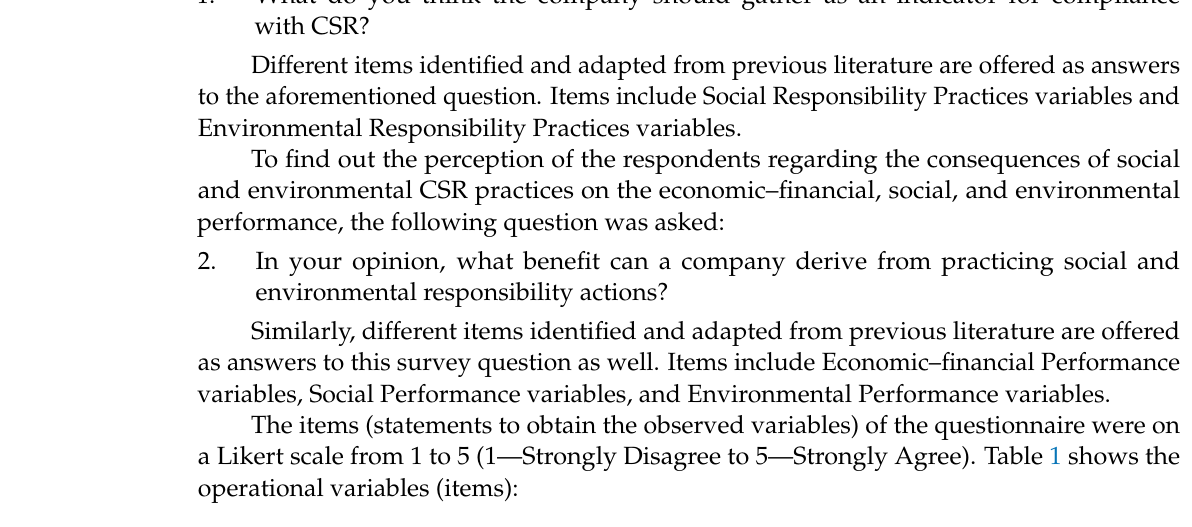
Table 1. Research Variables (Constructs) and Indicators (Survey questioned